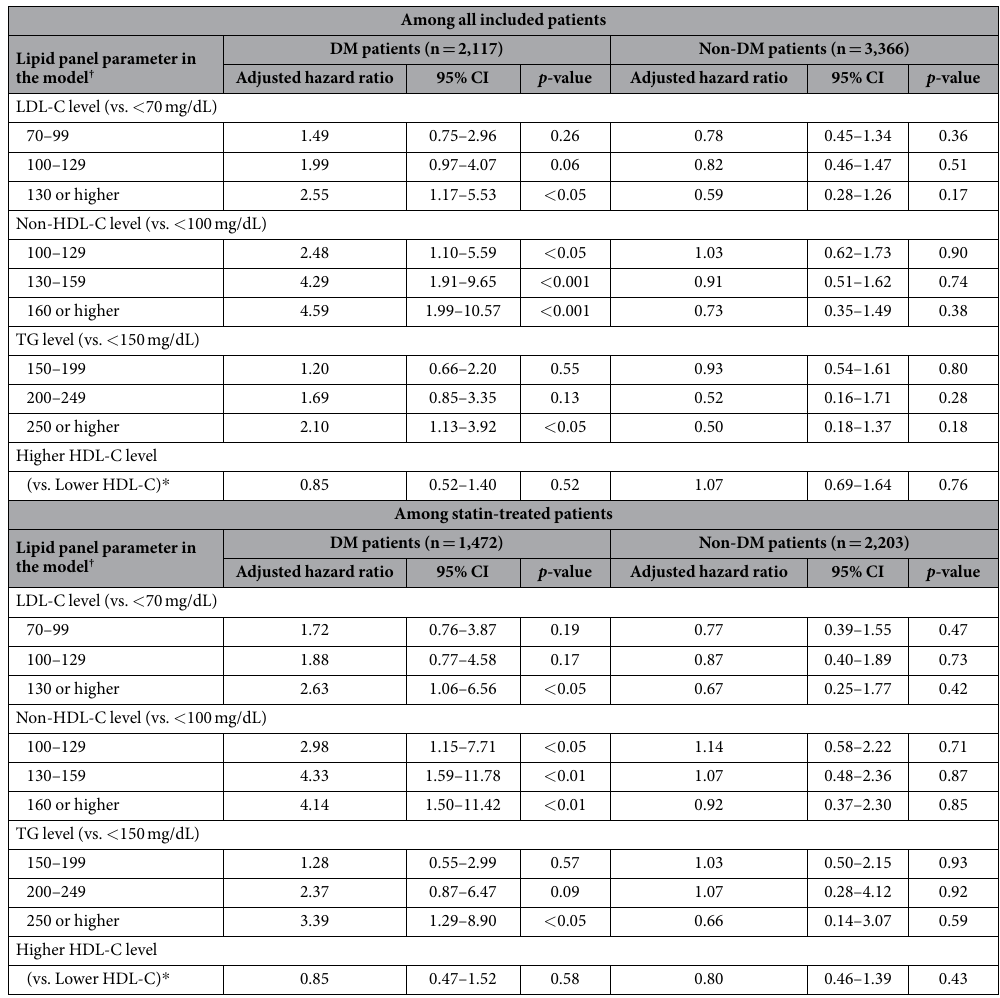
Table 4. Comparing the ability of various lipid parameters to predict MACE in diabetic and nondiabetic ASCVD patients. * Lower HDL-C was defined as < 40 mg/dL for male and < 50 mg/dL for female. † Each